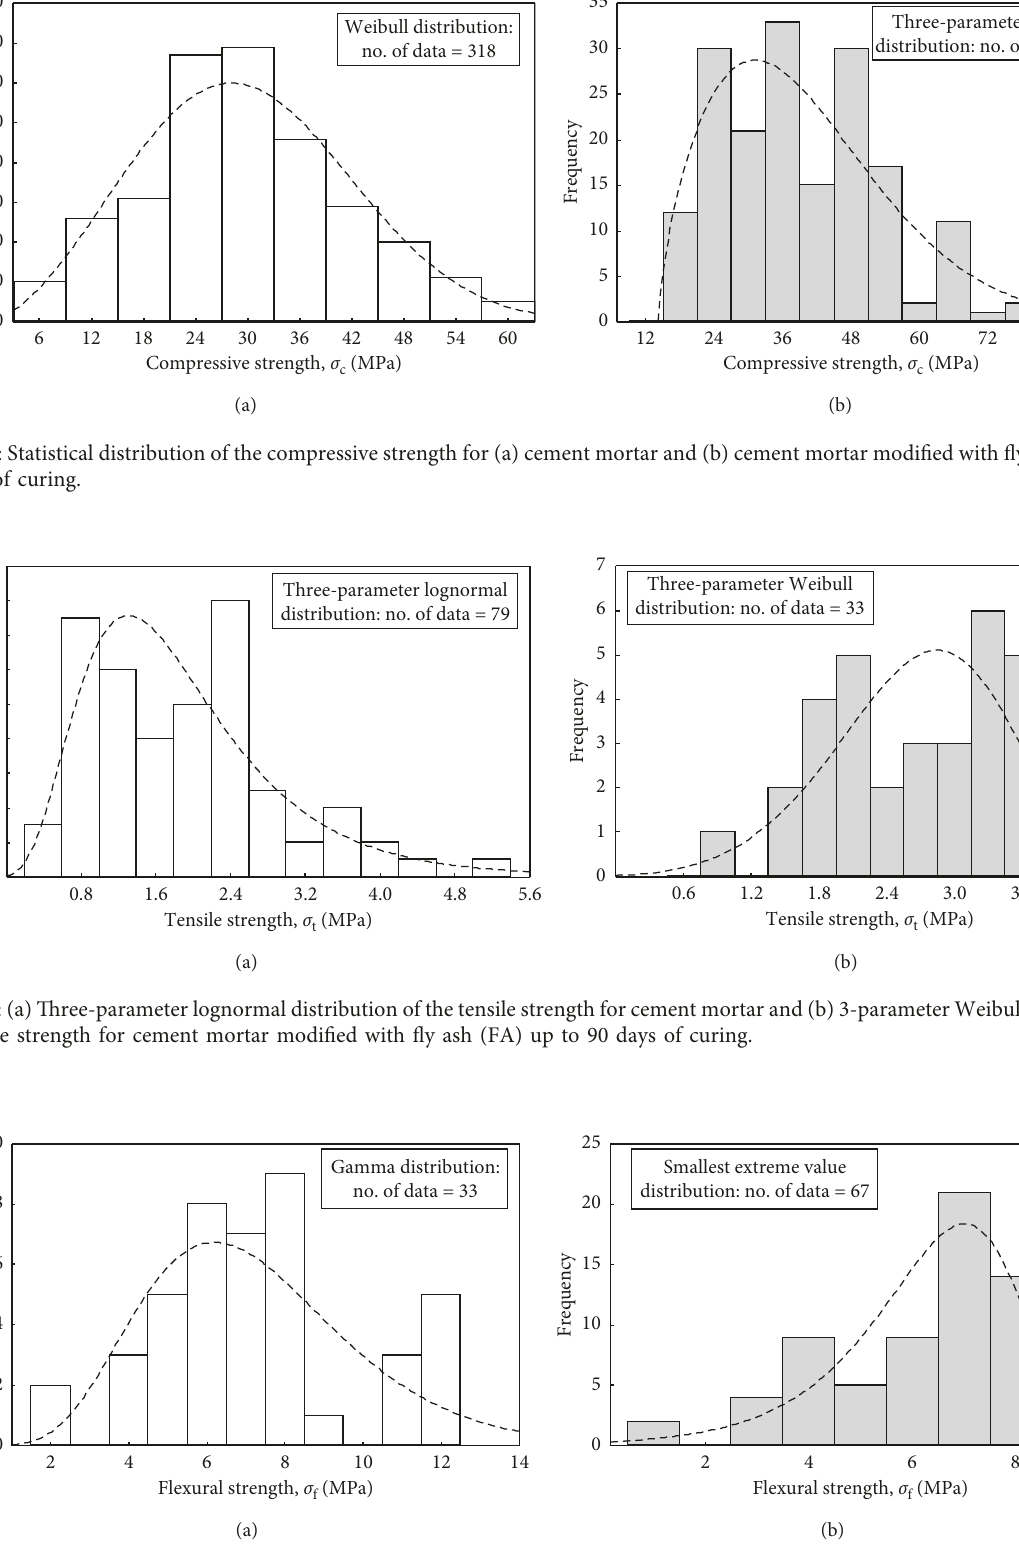
Figure 5: Statistical distribution of the flexural strength for (a) cement mortar and (b) cement mortar modified with fly ash (FA) up to 90 days of